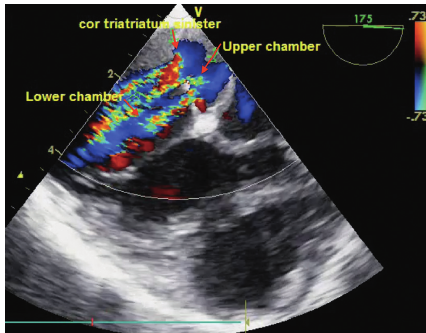
Figure 3: Selective pulmonary angiography showing AV malfor- mation in the upper part of the left